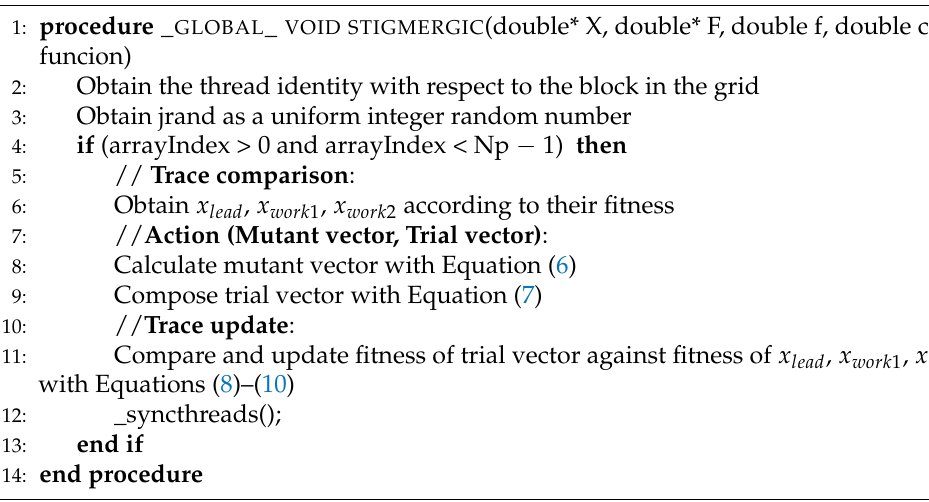
Algorithm 2 Stigmergy-inspired kernel of